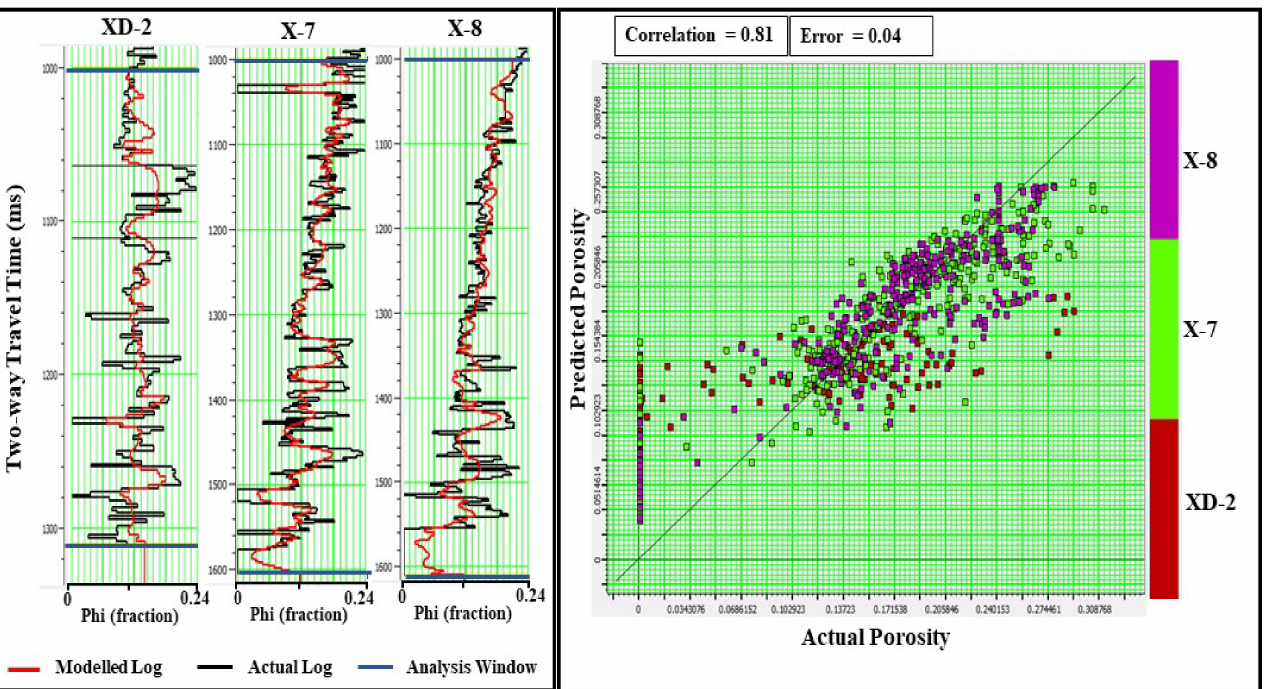
Figure 23. The error analysis window for ANN training demonstrates a 0.03 training error and a 0.83 correlation between the true and estimated porosity.